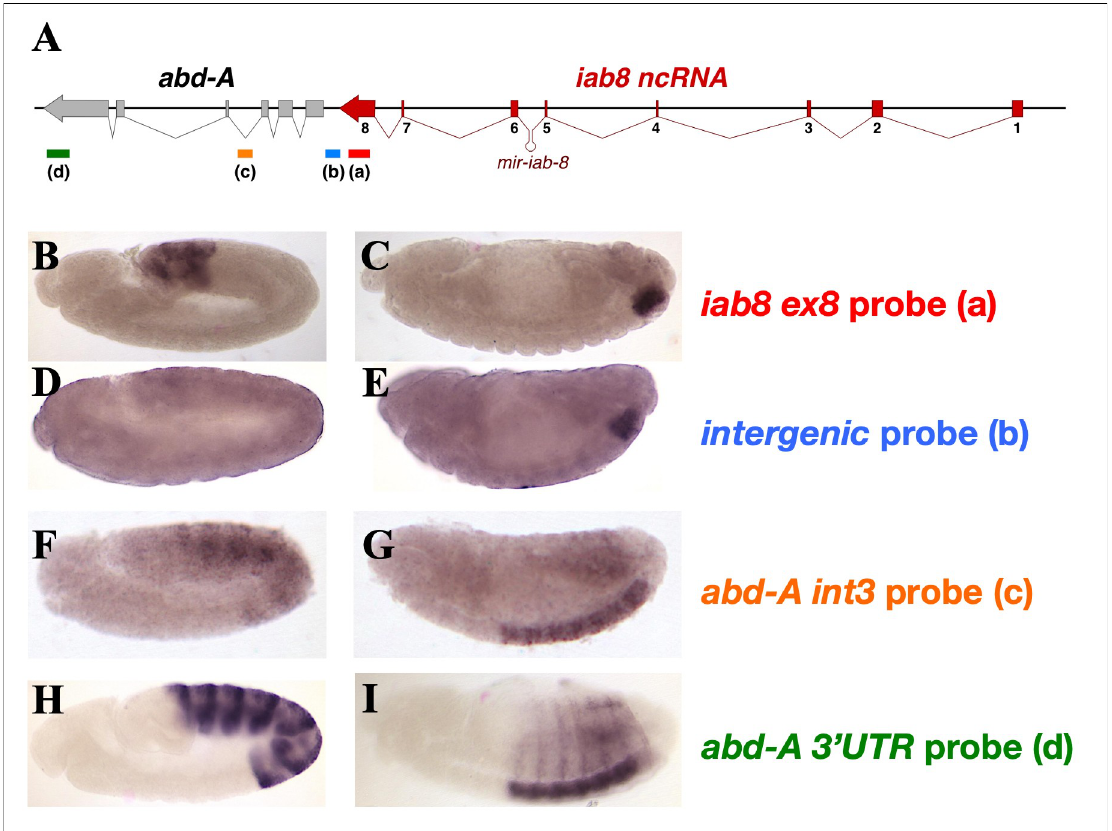
Fig 5. Detection of the iab- 8-ncRNA expression in wild-type embryos by different probes. Wild type embryos were hybridized with probes directed against different area of the iab-8/abd-A region. The locations of the probes are indicated by the colored lines (and letters a, b, c and d) beneath the genomic map. The names of the probes are indicated to the right of the embryos displayed in panels B-I in their respective colors. Panels B, D, F and H show germband extended embryos (about stage 9) while panels C, E, G and I show germband retracted embryos (stage